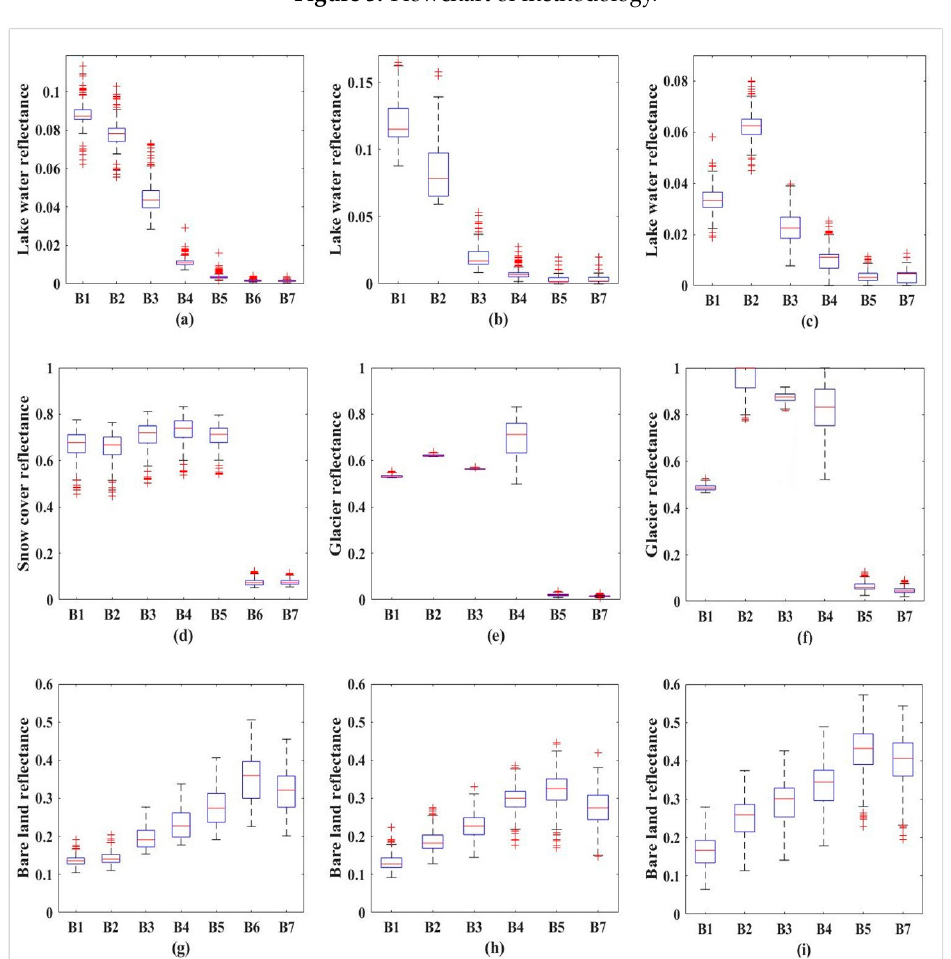
Figure 4. Reflectance distribution of three land cover types in three study regions. ( a ), ( b ) and ( c )